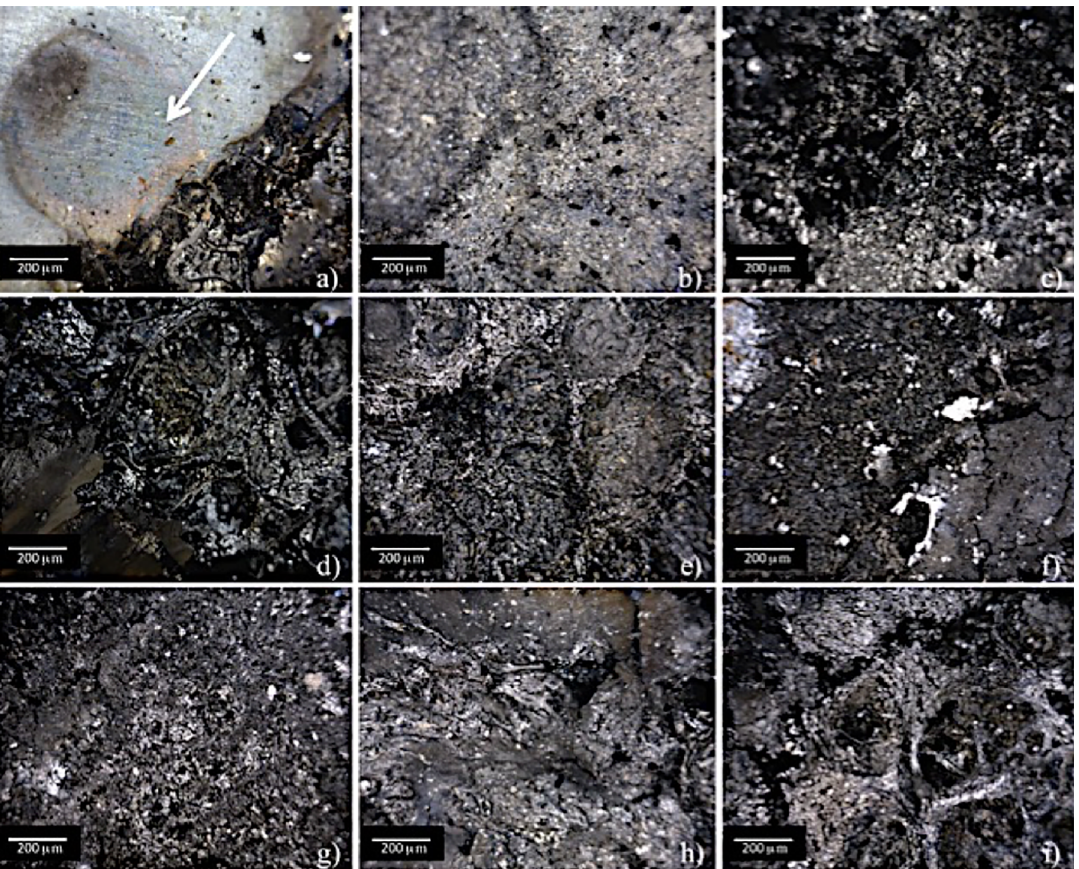
Figure 7. Optical images of the char layer after the fire test: a) epoxy resin, b) TAN5, c) TAN5-BM, d) TAN5-P, e) TAN5-BM-P, f) TAN10, g) TAN10-BM, h) TAN10-P and i) TAN10-BM-P.